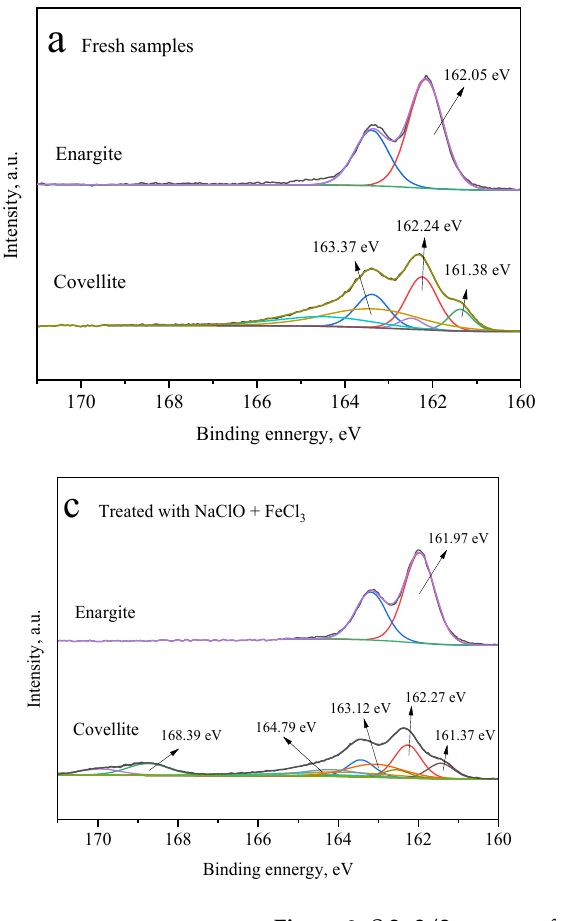
Figure 9. S 2p3/2 spectra of the covellite and enargite samples treated with different depressants: ( a ) fresh samples, ( b ) NaClO, and ( c ) NaClO + FeCl 3 .